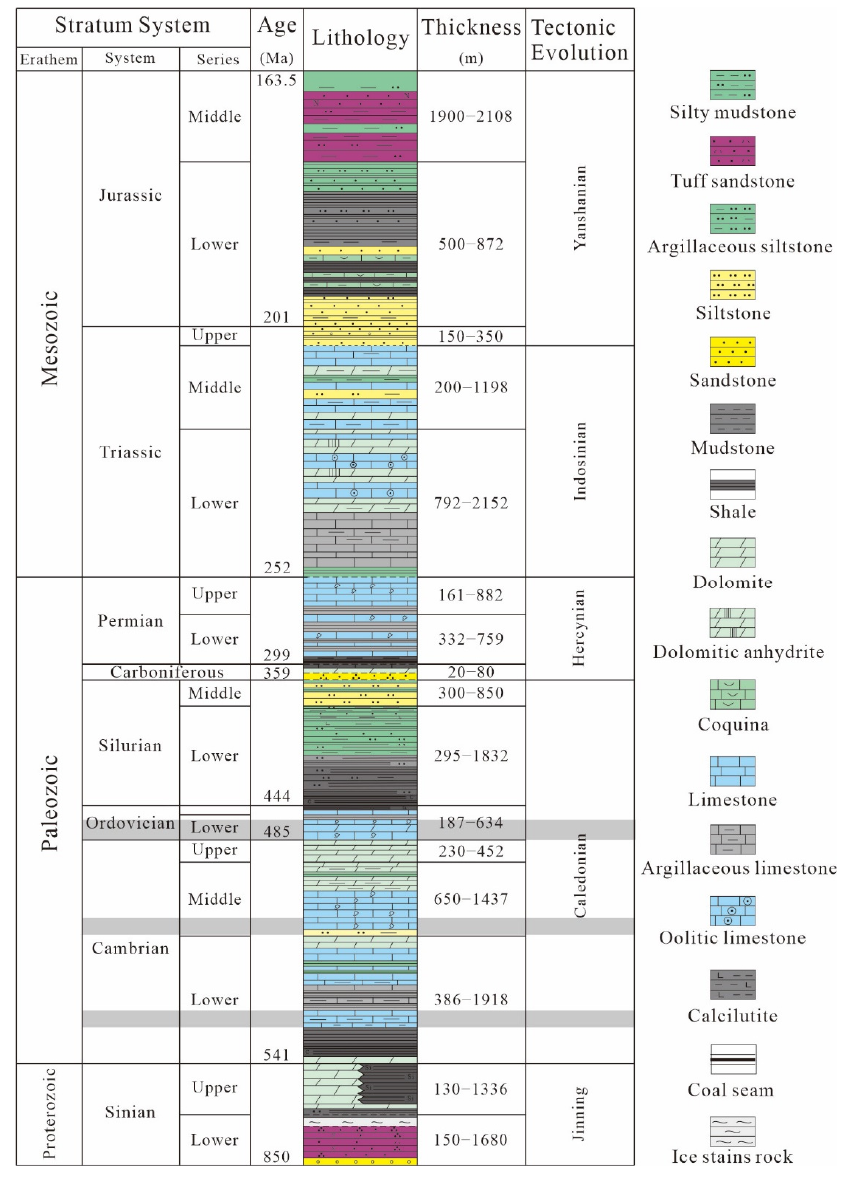
Figure 2. Schematic stratigraphic units of the margin of the eastern Sichuan